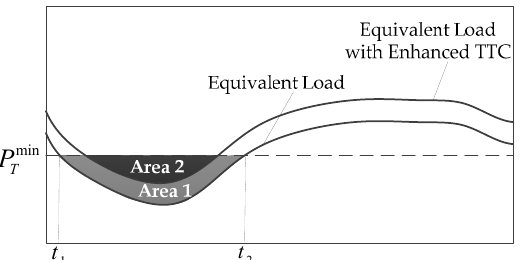
Figure 2. Schematic diagram of the impact of enhancing total transfer capability (TTC) on reducing curtailed wind power.